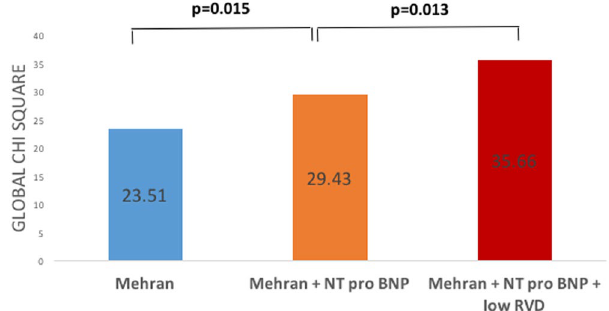
Figure 3. Incremental value of low retinal vessel density ( < 19.7 mm − 1 ) to predict AKI after ACS. Bar graphs illustrating the change in global chi-square value by the addition of low RVF and NT-proBNP level to a logistic regression model including the Mehran score. The addition of NT-proBNP level and low RVD significantly improved the overall chi-square, thereby demonstrating the incremental value of these parameters to predict AKI after ACS.